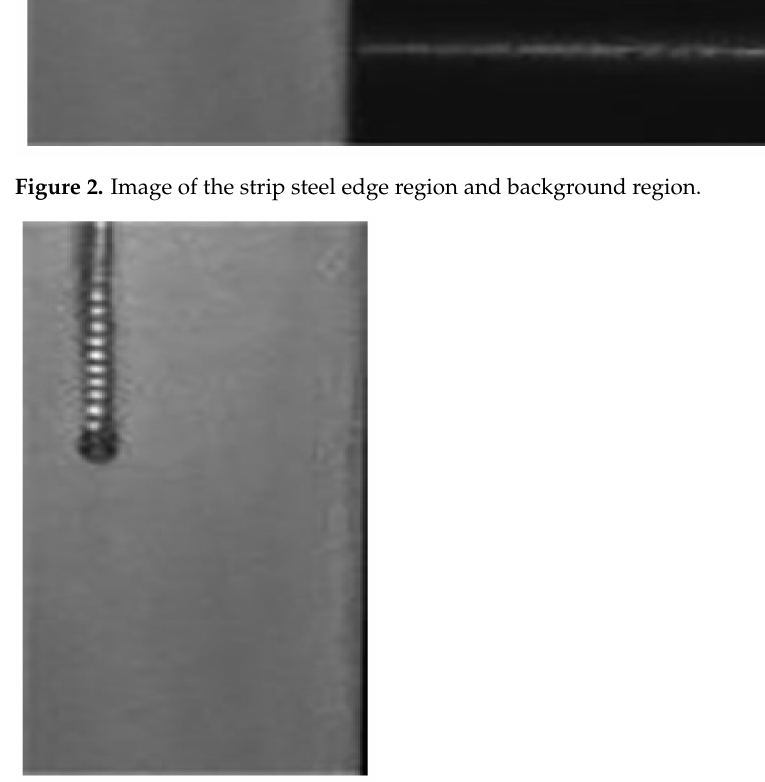
Figure 3. Image of a strip steel defect acquisition